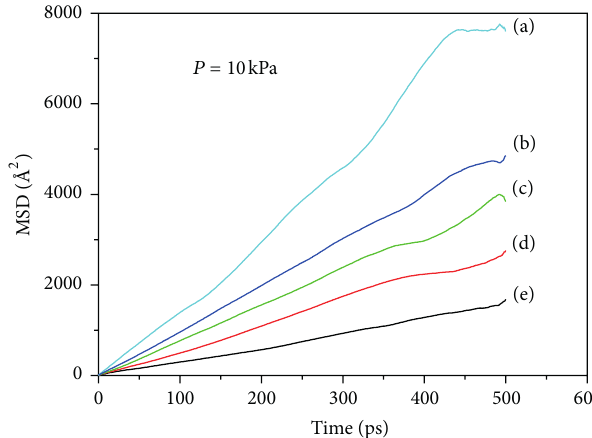
Figure 2: Mean square displacements of the center of mass of hydrogen diffusion at different pressures: (a) 10kPa, (b) 100kPa, (c) 600 kPa, (d) 1700kPa, and (e) 2700kPa at 77K.